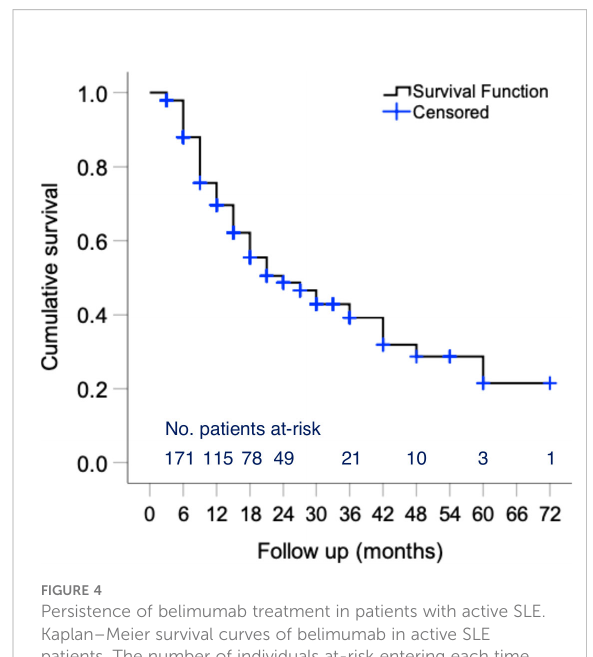
FIGURE 4 Persistence of belimumab treatment in patients with active SLE.